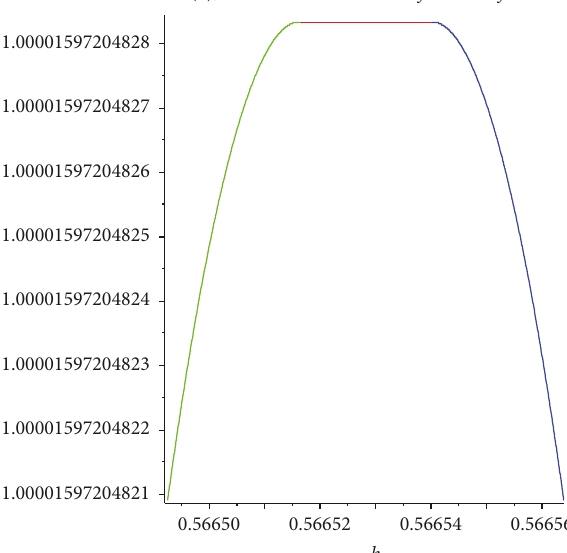
Figure 5: Plot of 𝑍 = 𝑌/𝑌 0 and 𝑏(𝑡) = 𝑎(𝑡)/𝑎 0 : 𝑏 = 1 is current age of the universe. Double transition from RS into ES and back from ES into